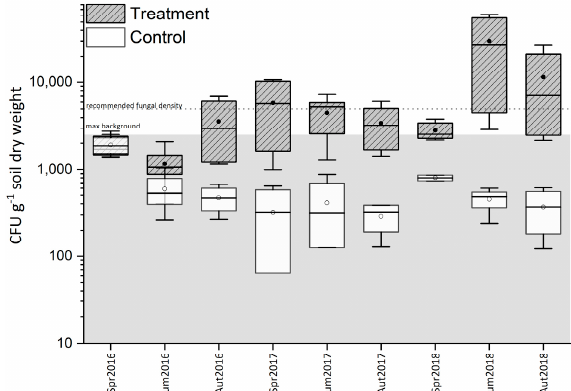
Figure 2. Metarhizium spp. abundance in Tyrolean field sites. Samples were taken in spring (Spr), summer (Sum), and autumn (Aut) from 2016 to 2018. Grey box indicates maximal background CFU levels before treatment, dotted line shows recommended fungal density. Lines and dots in box plots show median and mean CFU g − 1 soil dry weight, respectively; boxes show the 25th and 75th per- centiles, whiskers the 10th and 90th percentiles.